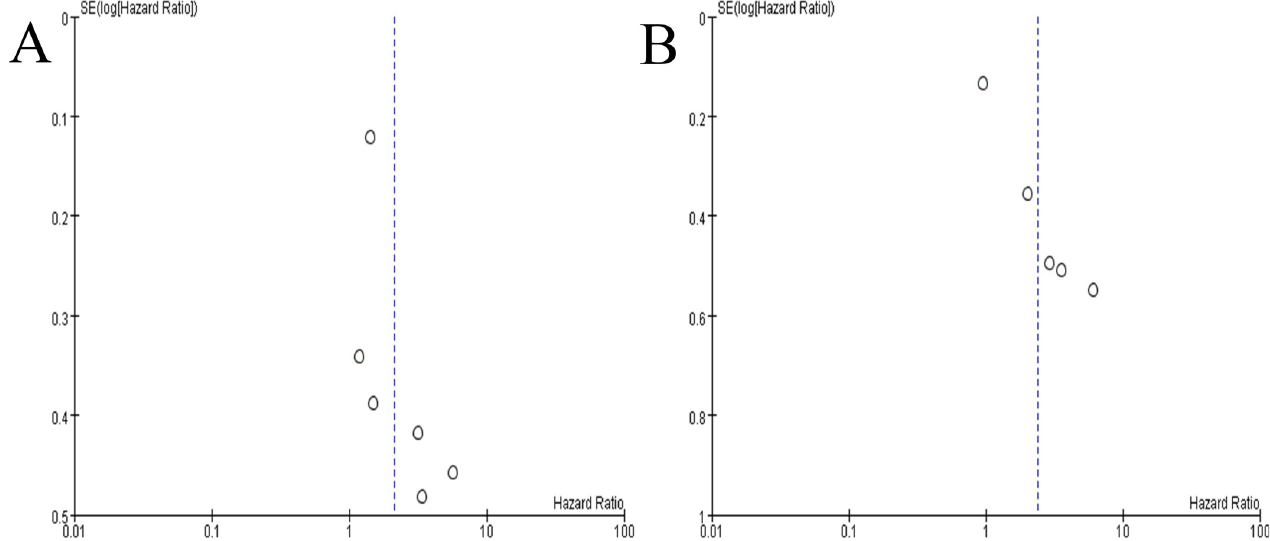
Fig 3. Funnel plots for assessing publication bias. (A) univariate data, (B) multivariate data.